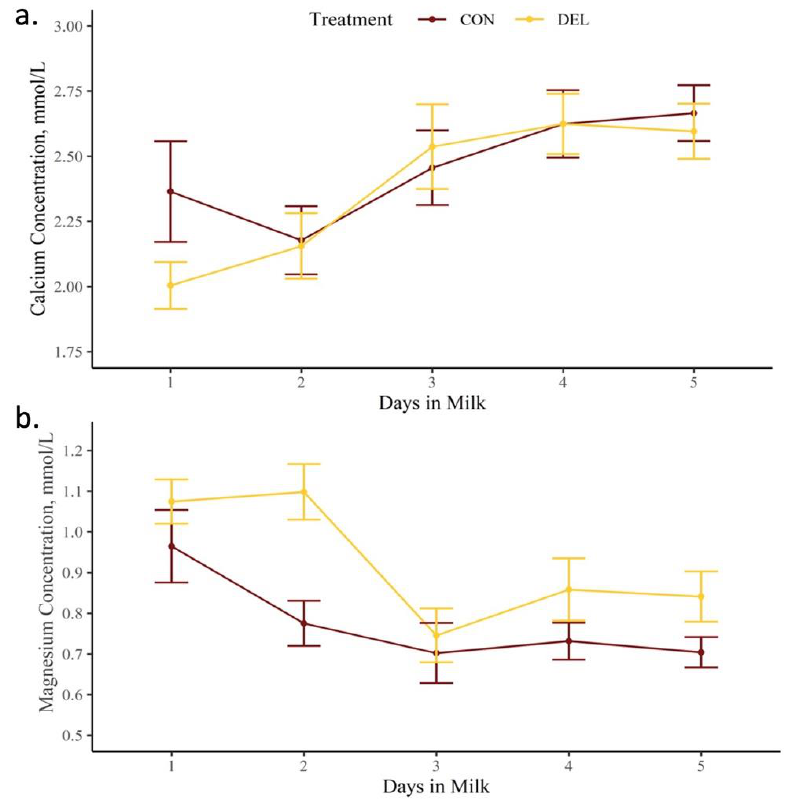
Figure 1. Blood plasma calcium ( a ) and magnesium ( b ) concentrations in multiparous cows admin- istered oral Ca boluses. Two Ca boluses were administered simultaneously within 24 h (CON) or between 24 and 48 h (DEL) of calving. Least square means ( ± SEM) from 1 to 5 days in milk (DIM) are reported for 9 CON and 9 DEL cows. Blood plasma Ca concentration did not differ between treatments ( p = 0.52), increased with DIM ( p < 0.001) and was not affected by the interaction of treatment by DIM ( p = 0.48). Blood plasma Mg concentration was greater in DEL cows ( p = 0.04), decreased with DIM ( p < 0.001), and was altered by the interaction of treatment * DIM ( p =